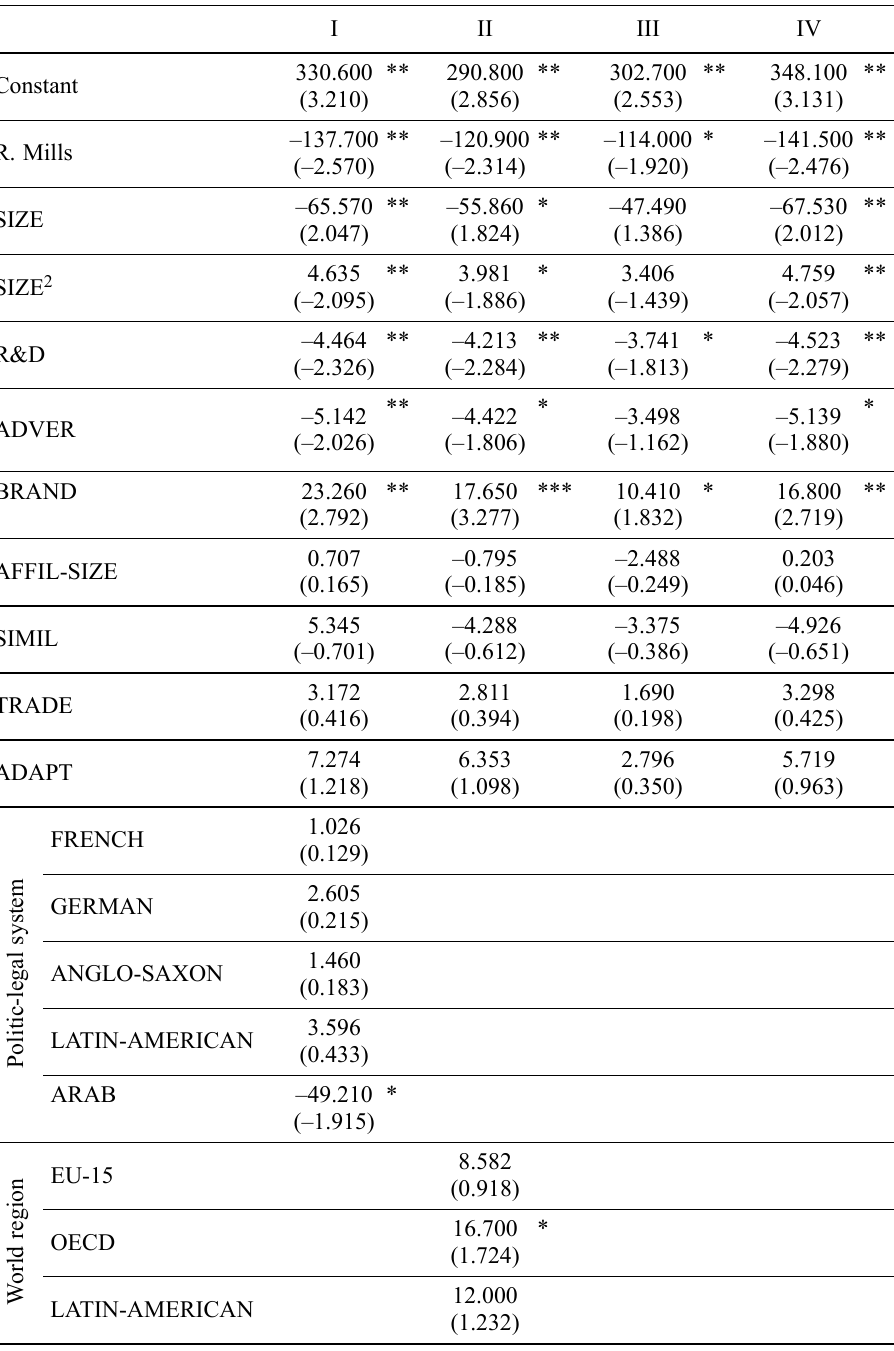
Table 5. Estimation on the participation on foreign affiliates and different